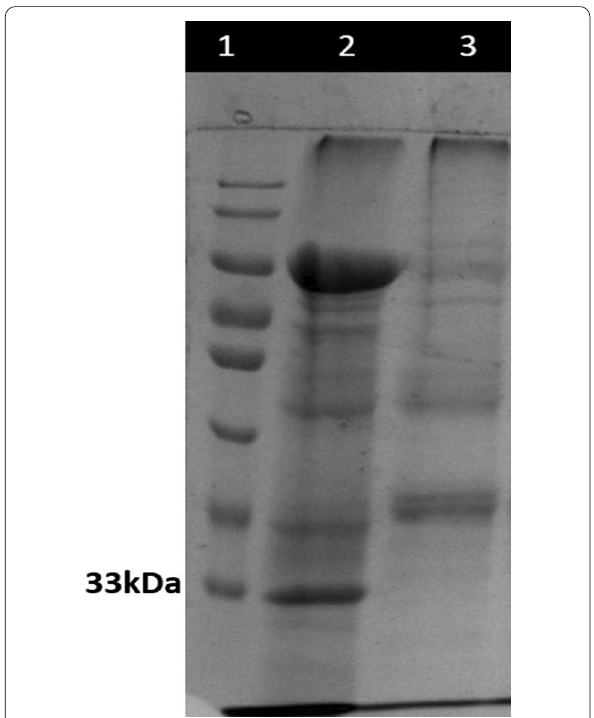
Fig. 4 Gel-doc images of protein profiling of the MDR S. typhi strain. Lane-1 represents the protein ladder used. Lane 2 indicates the presence of 33 kDa OmpA protein. The 33 kDa band is missing in the Lane3where S. typhi was treated with the plant extract for 24 h